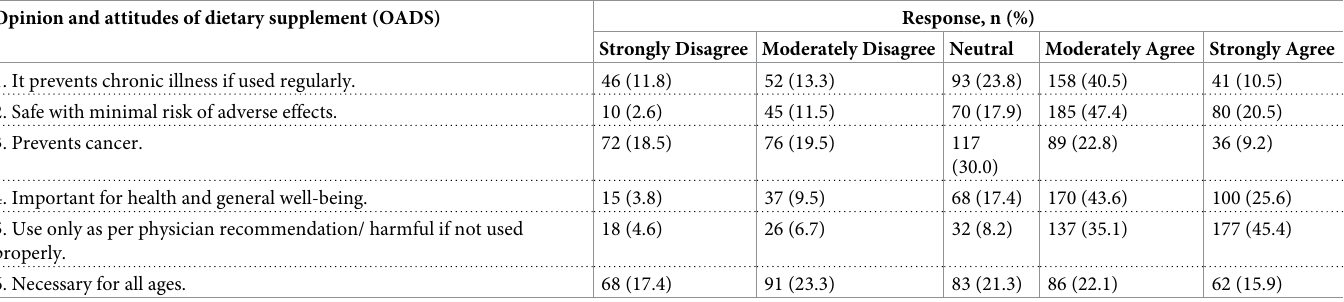
Table 3. Opinions and attitudes regarding dietary supplement among study